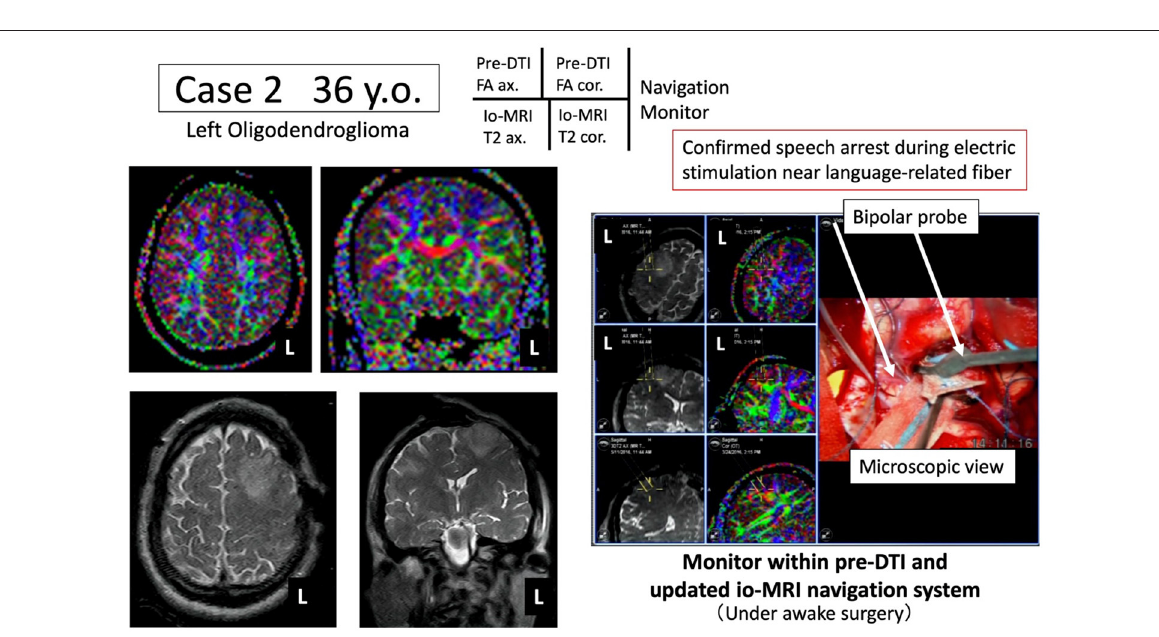
FIGURE 3 | Case 2: navigation based on pre-operative arcuate fasciculus language function information. Under awake craniotomy, tumor resection is performed while the arcuate fasciculus (green) is monitored in real time using the newly developed navigation